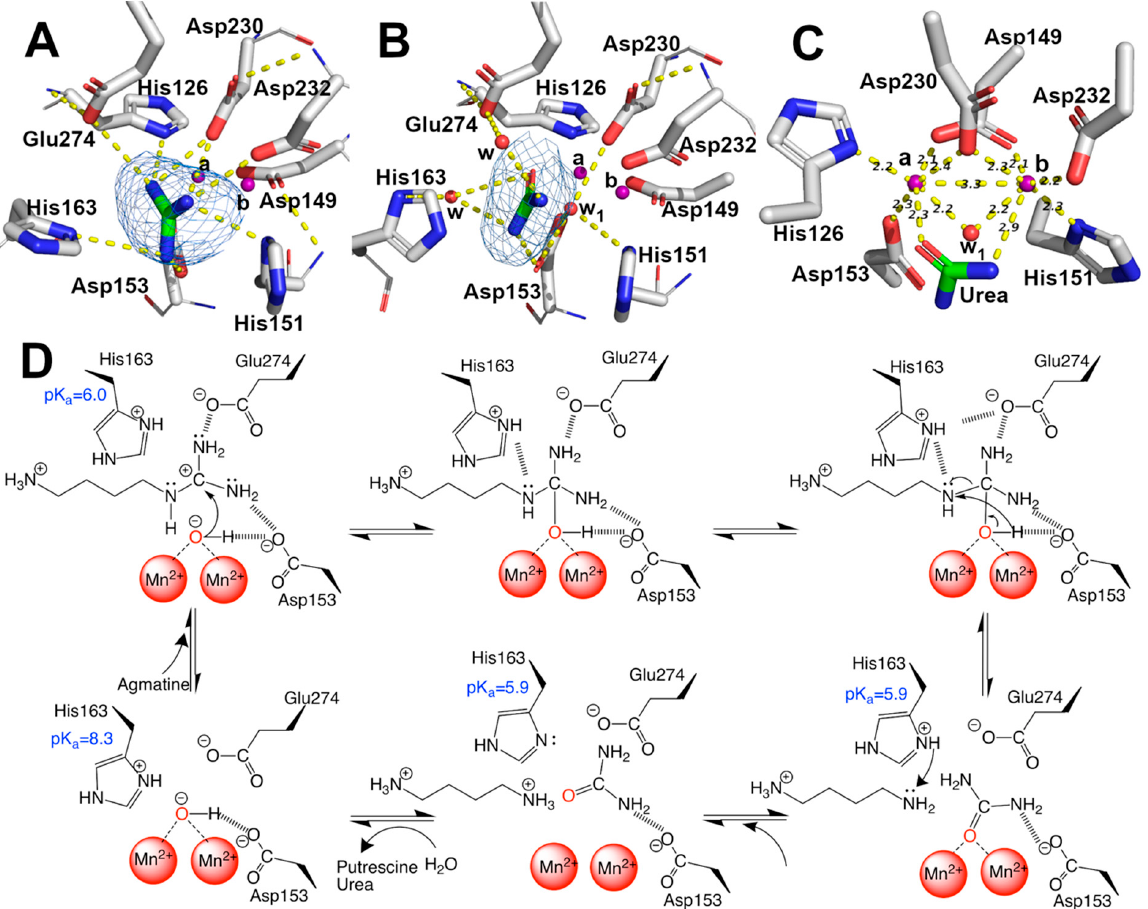
Figure 4. Mn 2+ , guanidine, urea binding-site, and catalytic mechanism. ( A – C ) guanidine, urea, and Mn 2+ binding sites, respectively. Omit maps are shown as blue mesh contoured at 3.0 sigma for guanidine and urea. Polar interaction in ( A , B ) and distances in ( C ) were calculated with Pymol 2.0. Sidechains are shown as sticks, and the carbon atom of protein in white, the main chain, is shown as a line. Ligand is shown as stick, and carbon is colored in green. Mn 2+ ions are shown as purple spheres and water as red spheres, indicating Mn a and Mn b . ( D ) proposal of catalytic mechanism of EcAGM, polar contacts are shown as dashed lines and pK a showed were estimated with PropKa3.1.